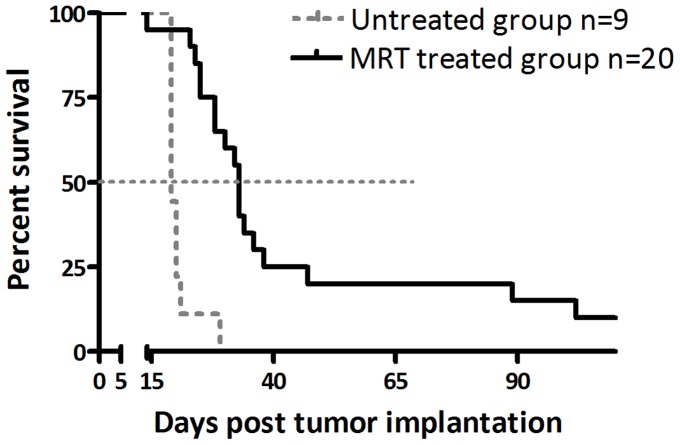
Kaplan-Meier representation of tumor-bearing rat survival.Intracerebral 9-irradiated (solid black line) or not (dashed grey line). MRT significantly increased the Median Survival Time of animals compared with untreated rats (33 days versus 19 days, log rank test: p<0.0001).